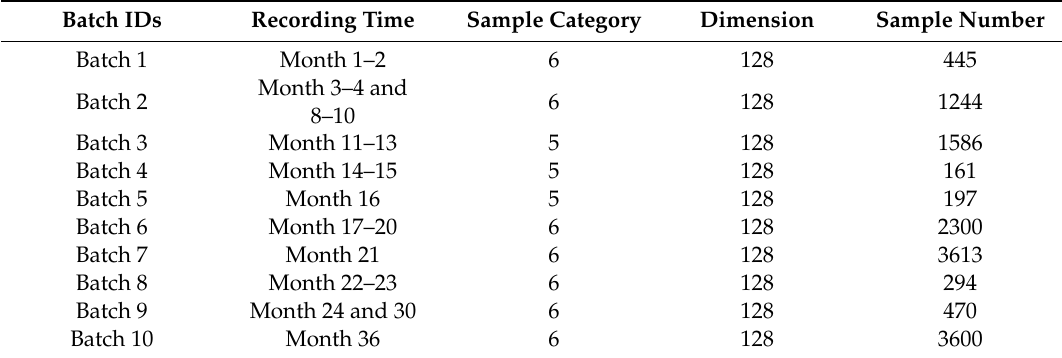
Table 1. Brief of drift